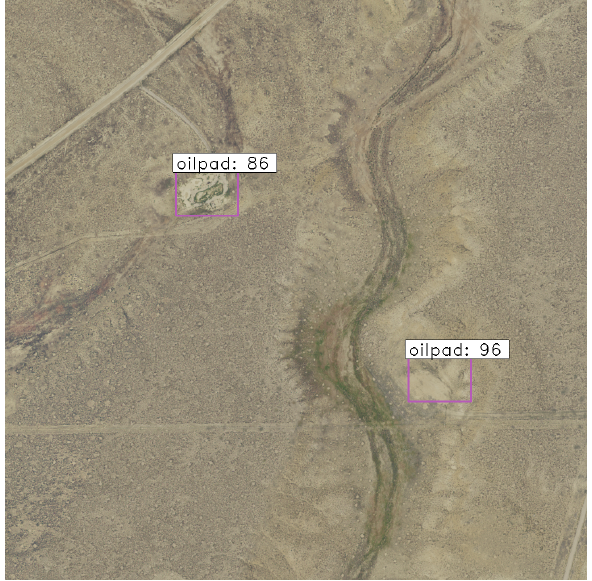
Figure 6. Model prediction on validation image from no oil pad set with abandoned oil pads with green patches and roads.